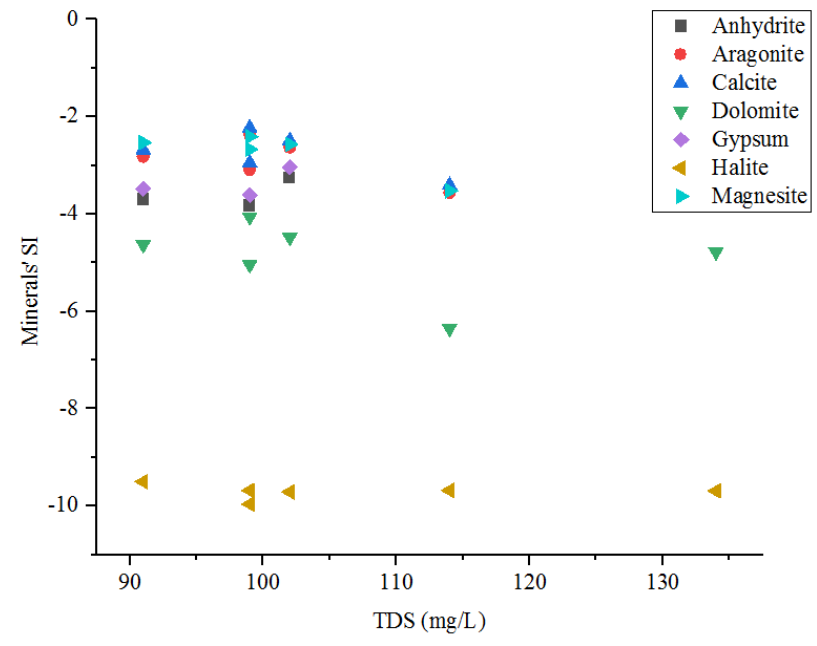
Figure 7. Variation of the saturation indices of different minerals. Table 5. Saturation indices calculated by PHREEQ.